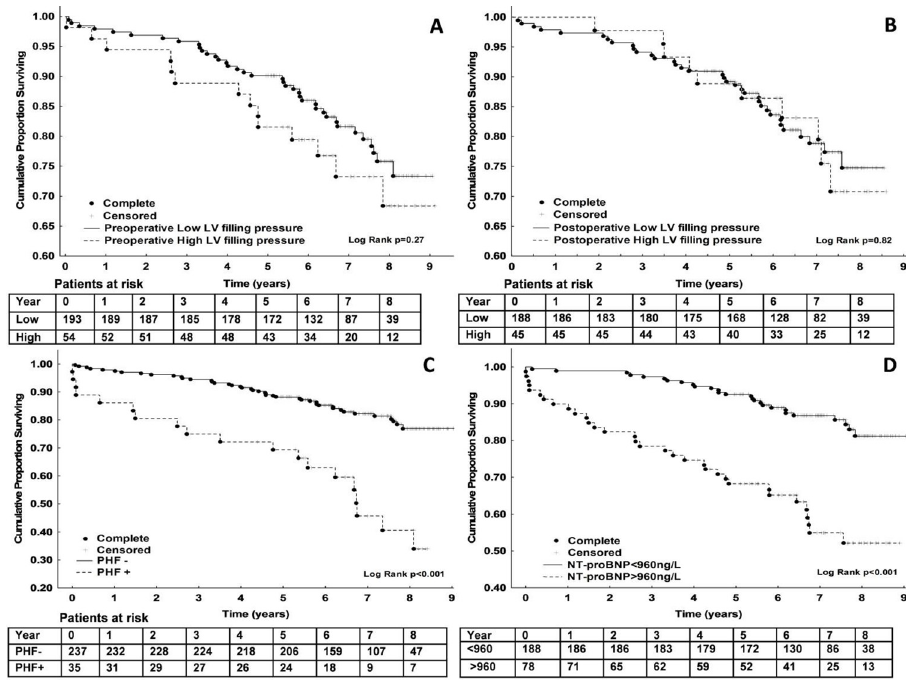
Fig 2. Kaplan-Meier survival curves categorized according to diastolic function before surgery (A), diastolic function at the 6-month postoperative follow-up (B), presence of PHF (C), and preoperative NT-proBNP above or below 960 ng/L